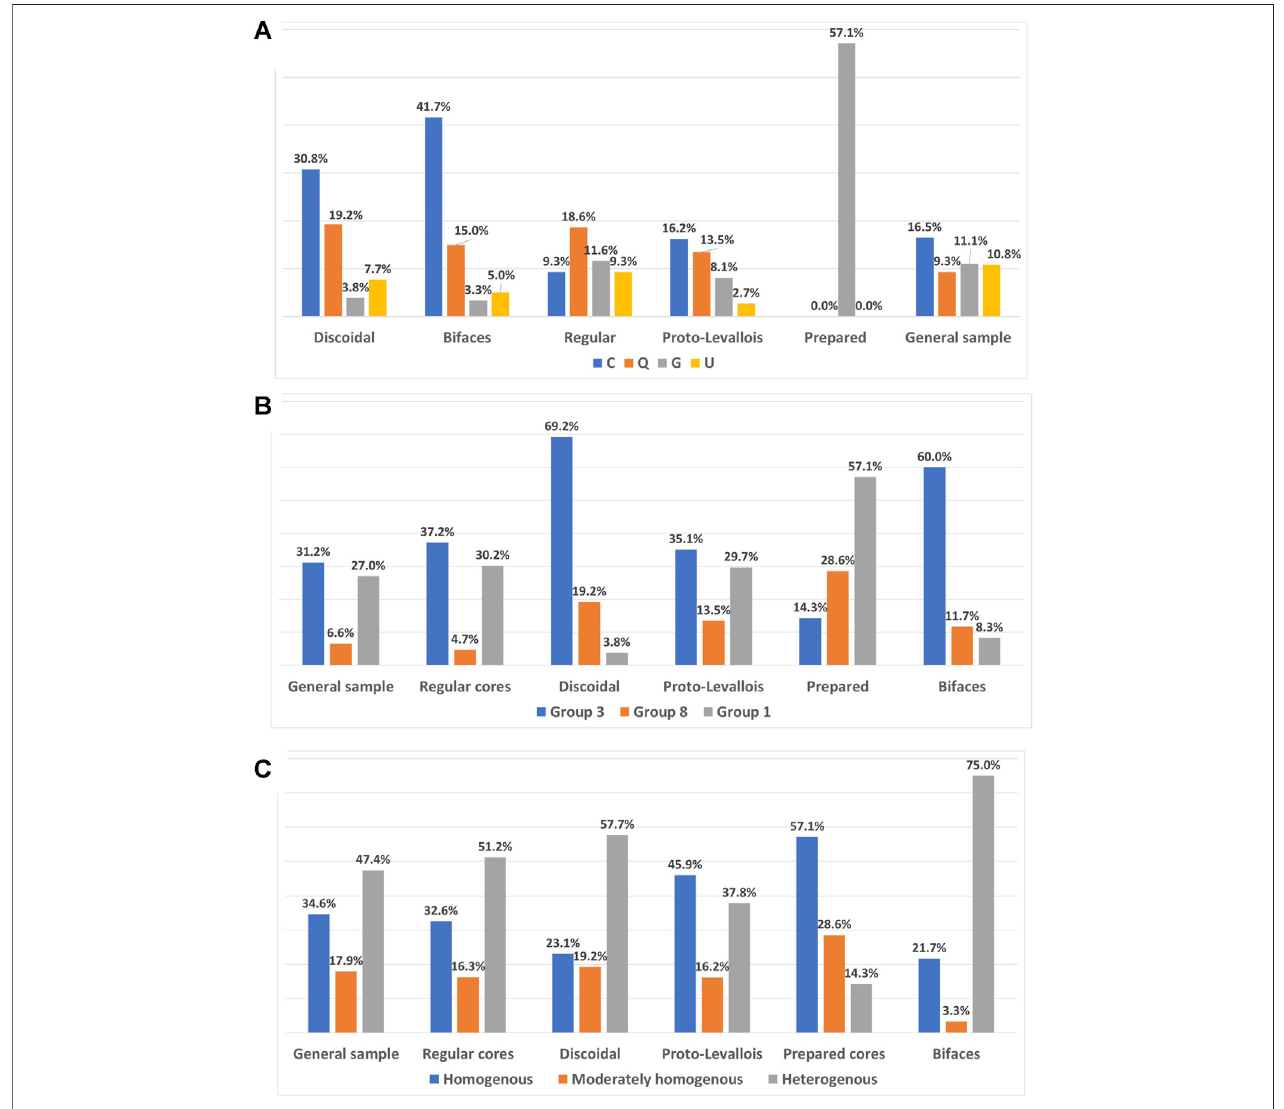
FIGURE 6 | (A) The frequency of major fl int types in the general sample, the bifaces and the four core groups: discoid, Levallois, prepared (general) and “ regular ” cores.Notethatnotall fl inttypesareincludedinthischart,resultinginasumlowerthan100%foreachcategory; (B) TheproportionsofGroups3,8and1inthedifferent analyzed categories; (C) The proportions of artifacts with different degrees of homogeneity by groups.